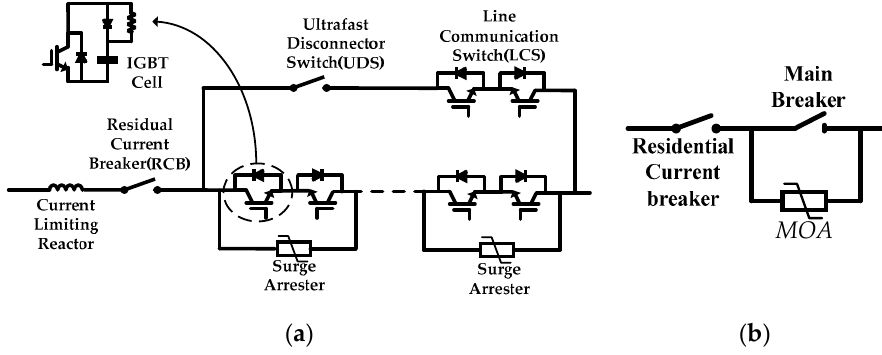
Figure 14. ( a ) Direct current circuit breaker topology, ( b ) simplified simulation model.